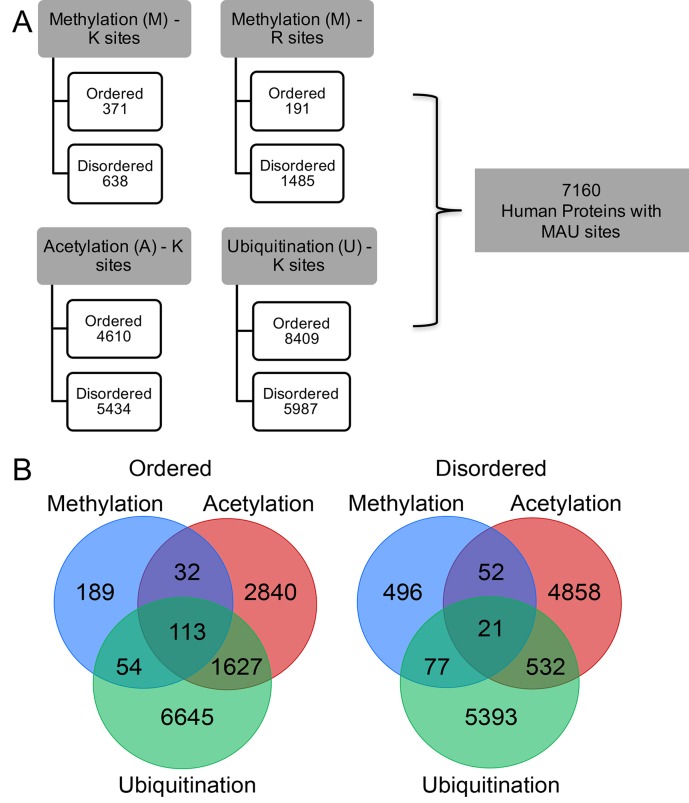
Overview of the number of methylation, acetylation and ubiquitination sites and the coincidence of different MAU types at the same residue in ordered and disordered regions.(A) total number of MAU sites in ordered and disordered regions of 7160 human proteins showing that the higher number of MAU sites in disordered regions than in ordered regions and ubiquitination sites show preference for ordered regions. (B) Venn diagram illustrates the co-incidence of MAU (i.e., how many can have two or three different MAU at the same residue) in ordered and disordered regions.